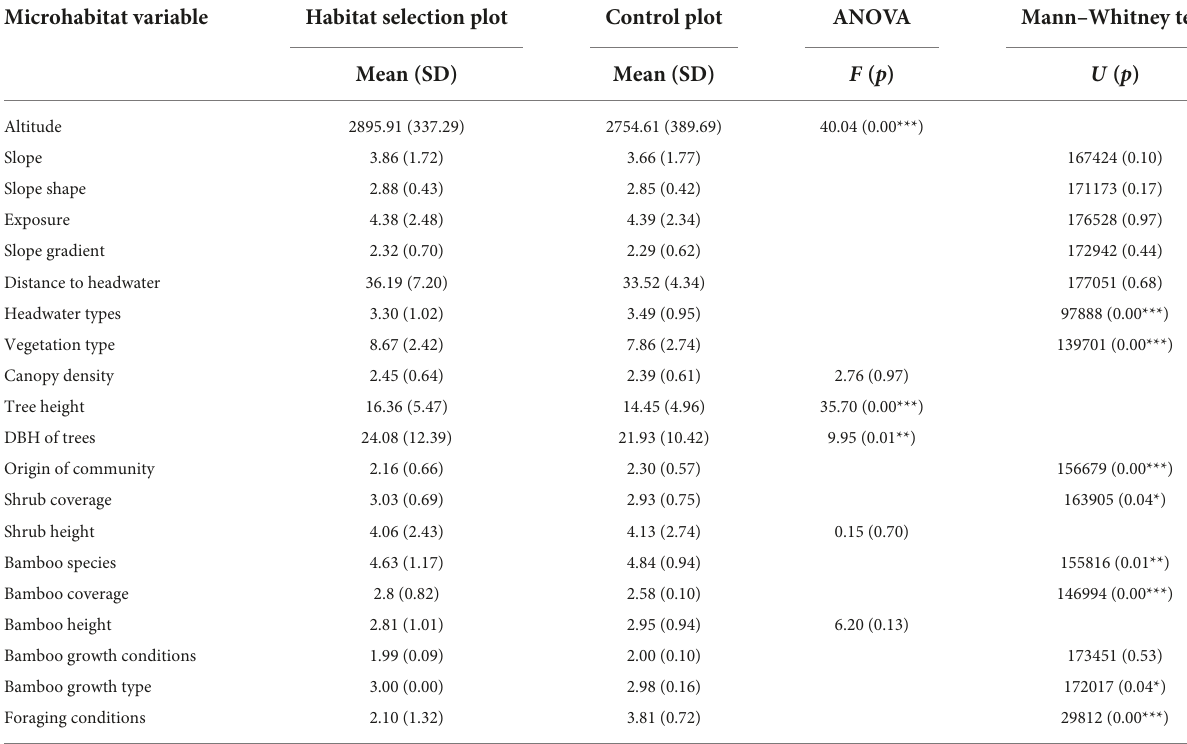
TABLE 2 Comparison of variables in habitat selection plots and control plots in the study area by analysis of variance (ANOVA) and Mann–Whitney U tests. Microhabitat variable Habitat selection plot Control plot ANOVA Mann–Whitney test Mean (SD) Mean